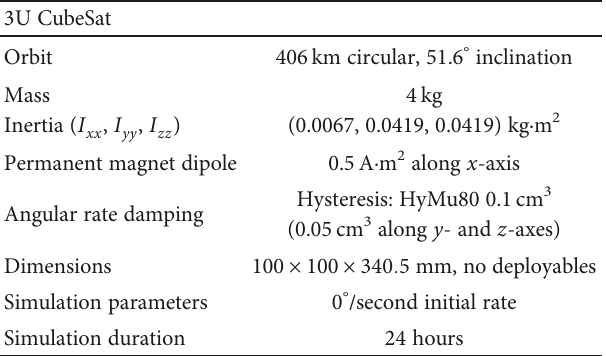
Figure 5: Simulated 3U CubeSat at ISS orbit, neglecting aerodynamic torques. This fi gure shows magnitude of environmental torques during 250 minutes in the steady state. Magnetic torque is two orders of magnitude larger than gravity gradient torques, which results in tracking of the magnetic fi eld. Magnetic hysteresis losses e ff ectively provide angular rate damping.